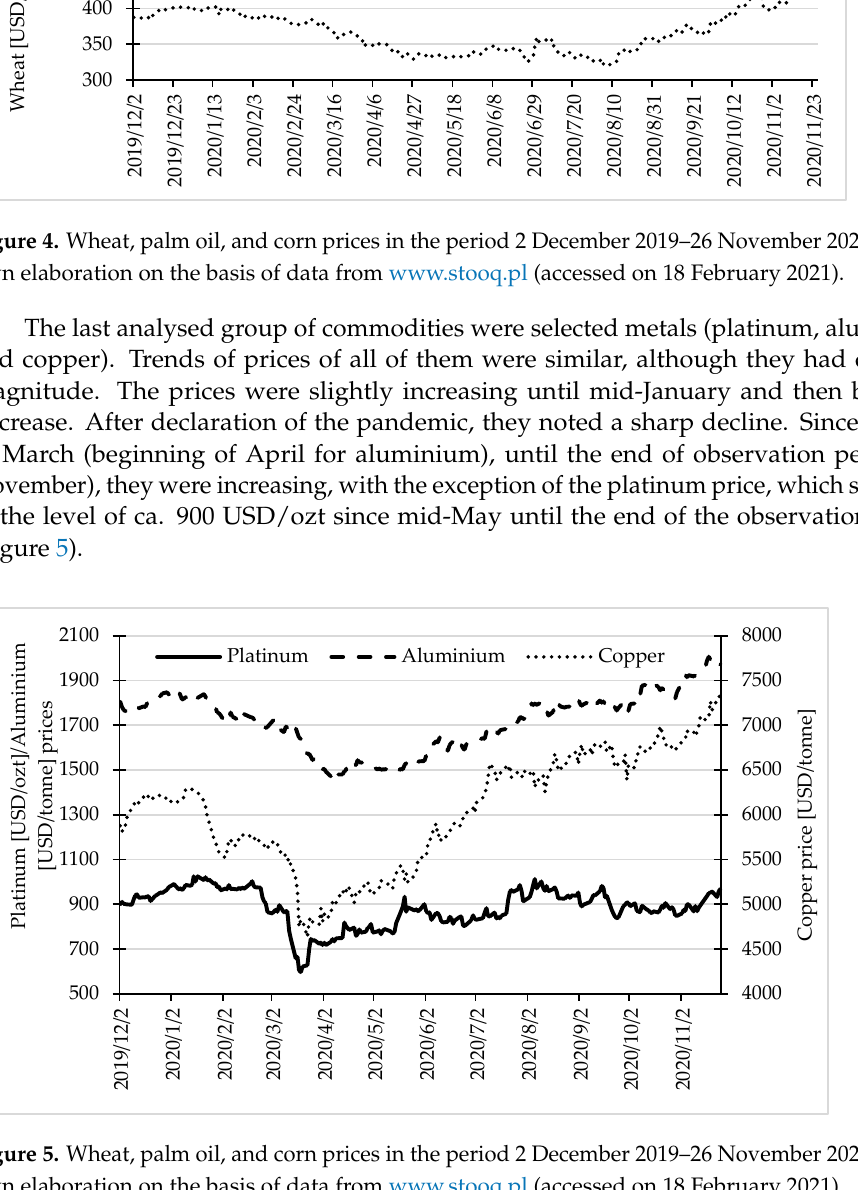
Figure 4. Wheat, palm oil, and corn prices in the period 2 December 2019–26 November 2020.